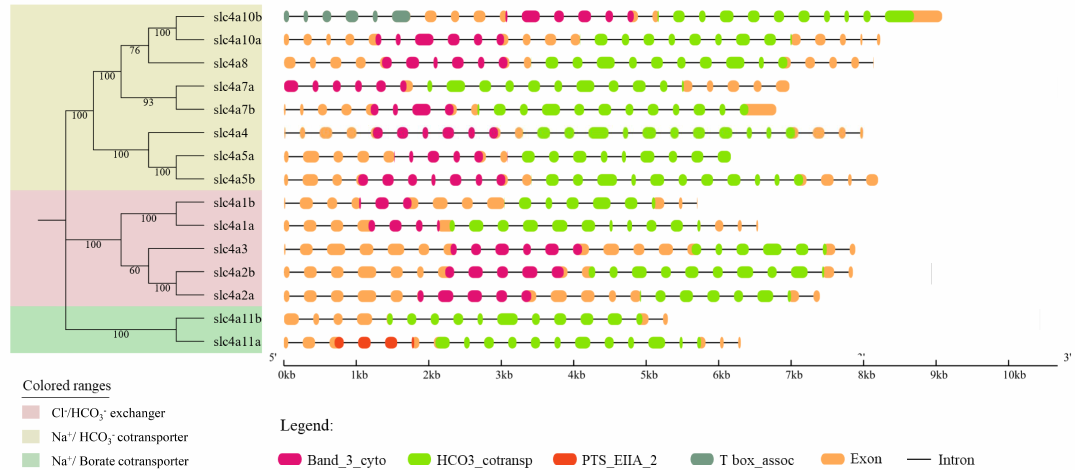
Figure 4. Schematic representation of gene structures of slc4 genes in spotted sea bass. The phylogenetic relationship was shown on the left. The boxes represented exons and lines were intron. The functional domains were marked with different colors.